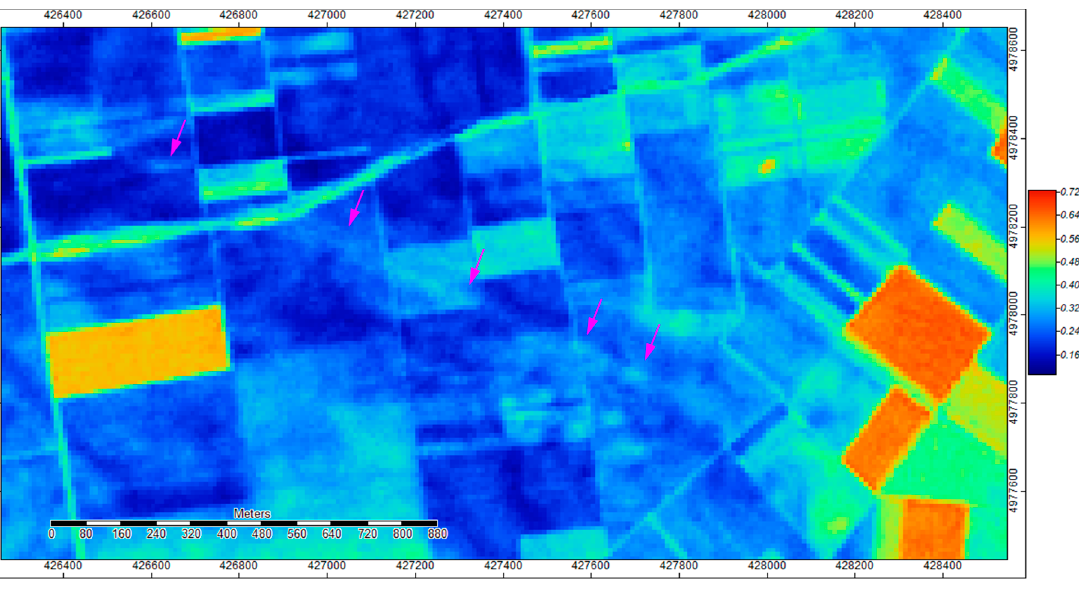
Figure 4. Details of the output image of RN application to the Sentinel-2 image. The crop-mark n.2, identified as the Roman road, is marked by the magenta arrows.